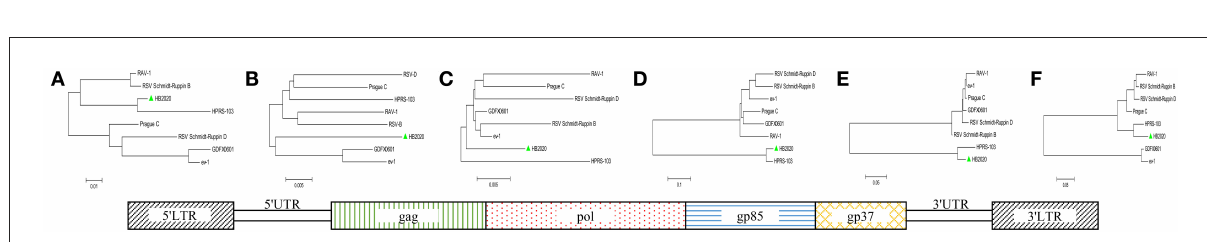
FIGURE4 ALV isolate HB2020 and other ALVs were compared in terms of segmental sequences. The genome sequences were divided into functional areas, and each segmental sequence underwent sequence alignment. The genome structure of the isolate HB2020 is shown in the bottom